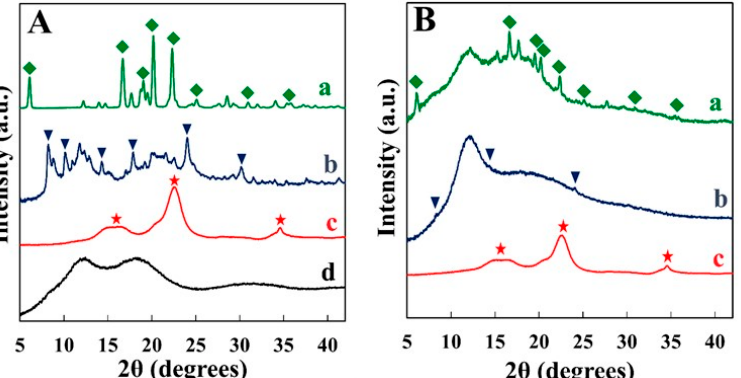
Figure 10. XRD patterns of ( A ) pure materials: (a) ibuprofen, (b) tetracycline, (c) nanocellulose, and (d) PEMA, ( B ) composite coatings: (a) PEMA-ibuprofen, (b) PEMA-tetracycline and (c) PEMA-nanocellulose (peaks corresponding to JCPDS files: ◆ -0032-1723 ▼ -039-1985, ⋆ -058-1718).